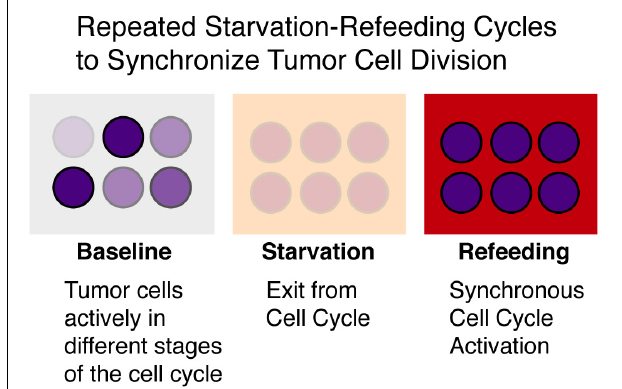
FIGURE 8 | Cycles of transient starvation/FMD are predicted to help synchronize tumor cell division and further reduce heterogeneity. At baseline tumor cells are dividing at different rates and are in different stages of the cell cycle. Following starvation, the division of tumor cells that are sensitive to environmental nutrient concentrations is stalled. Many tumor cells are not sensitive to nutrients and continue to divide and are sensitive to chemotherapy. Subpopulations of tumor cells that are sensitive to nutrients, may stop division and enter persistent, hypometabolic states during starvation. However, upon re-feeding, nutrient sensitive tumor cells are expected to synchronously enter the cell cycle, as is observed for some cancer cell lines in vitro upon serum-induced cell cycle activation. This activation is expected to make the cell population more homogeneous and vulnerable to